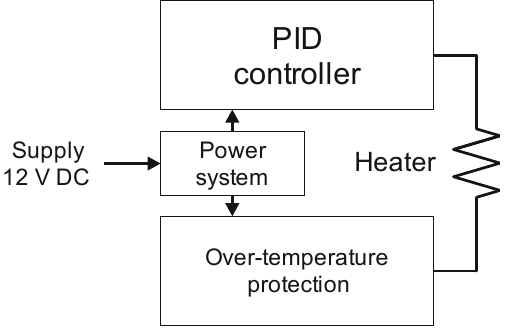
Figure 7. A block diagram of the temperature-stabilization system.